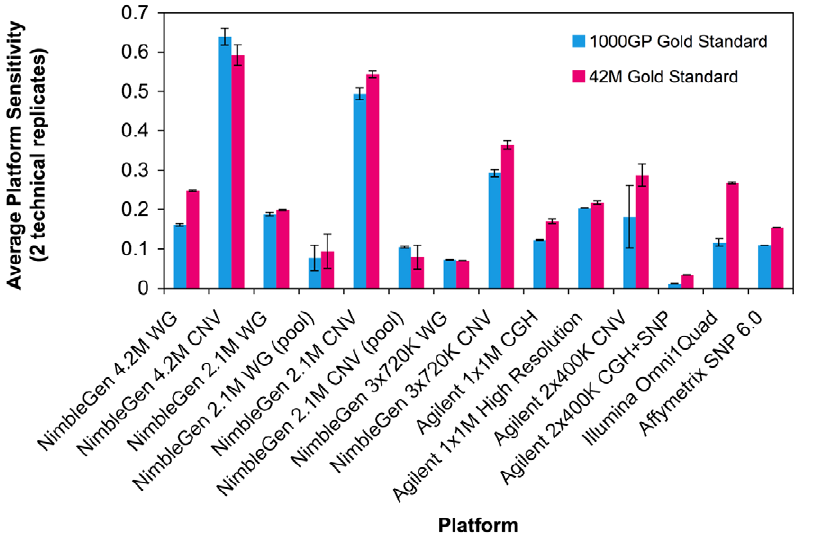
Figure 4. Array sensitivities to detecting Gold Standard CNVs. Depicted are the average corrected platform sensitivities based on two technical replicates for each platform, except the Affymetrix SNP 6.0. Corrected sensitivities were calculated using only those Gold Standard CNVs that were detectable by at least one platform. Blue bars show sensitivity to the detectable 1000GP GS and pink bars show sensitivity to the detectable 42 M GS.